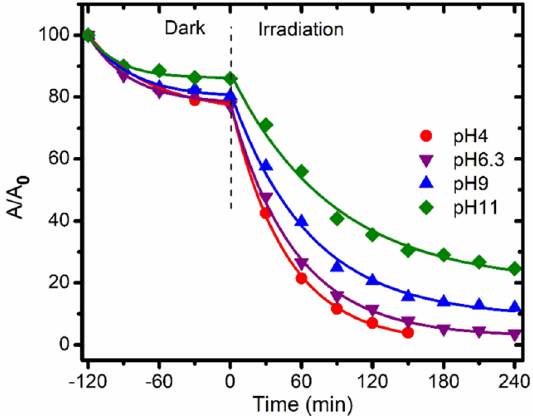
Figure 8. Degradation ratio of 2-naphthol of Sr 0.95 La 0.05 TiO 3 powder at different 2-naphthol solution pH values. Conditions: catalyst, 0.1 g; 2-naphthol (10 ppm, 200 mL); pH 4–11; 30 °C; Exo Terra Natural Light (Repti Glo 2.0 Comp Fluor 26W PT2191-220, Illuminance: 15350 Lux, 400–700 nm).